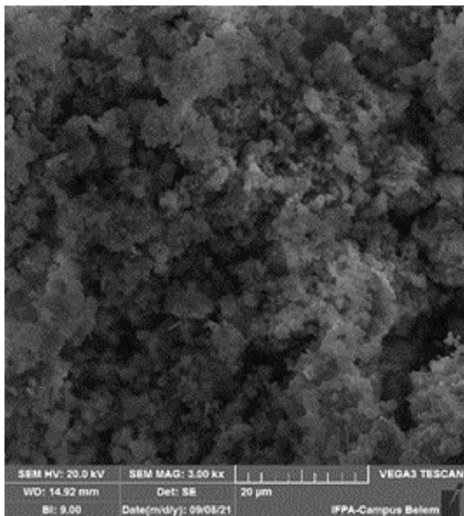
Figure 6. Red mud residue sample,